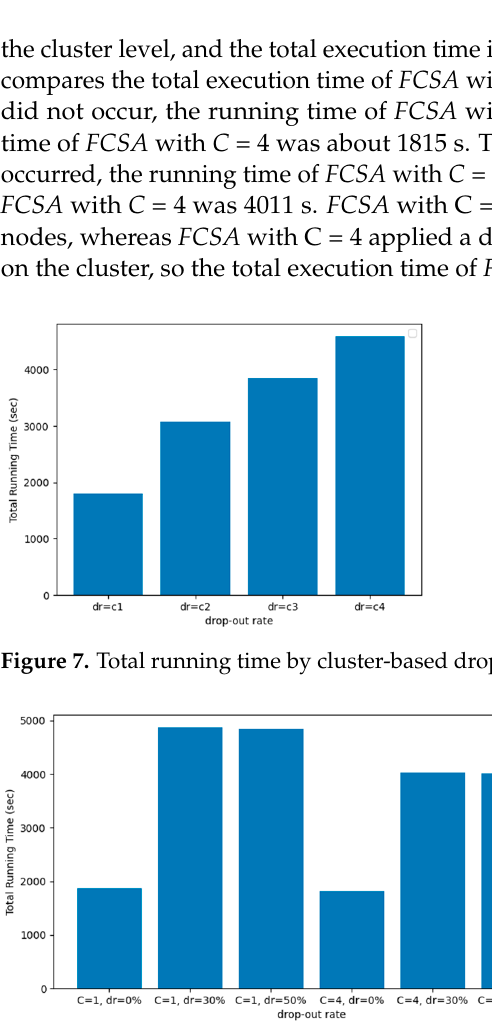
Figure 6. Accuracy by cluster-based dropout and training weights ( 𝜆 ).